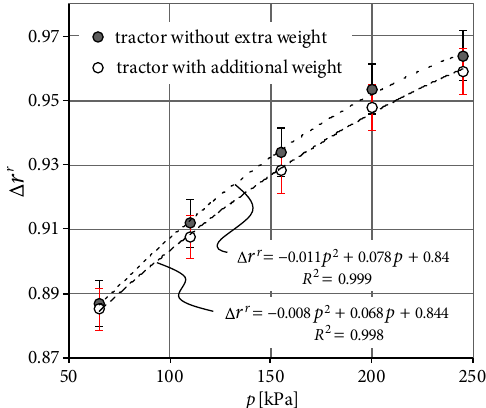
Fig. 3. Rear wheel tire deformation coefficient dependences on air pressure in the tires when tractor is moving at a speed of 1.43 m/s without ballast weights and with 650 kg ballast